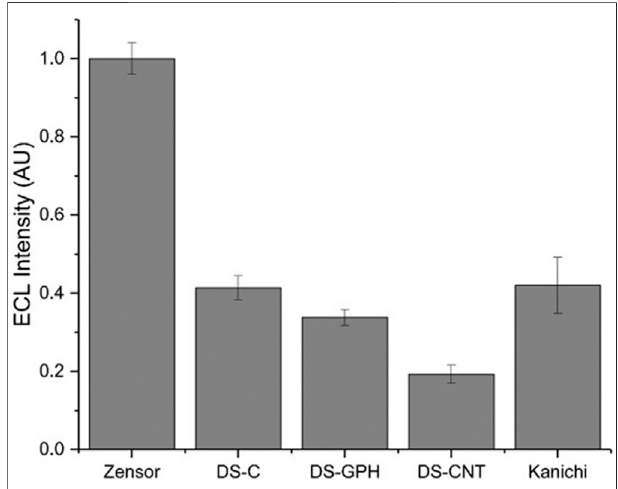
FIGURE4 | Relative ECL intensity (corrected for workingelectrodearea) for bead-based DNA assay (100 mM TPrA, 0.2 M PBS, pH 7.5, n (cid:2)